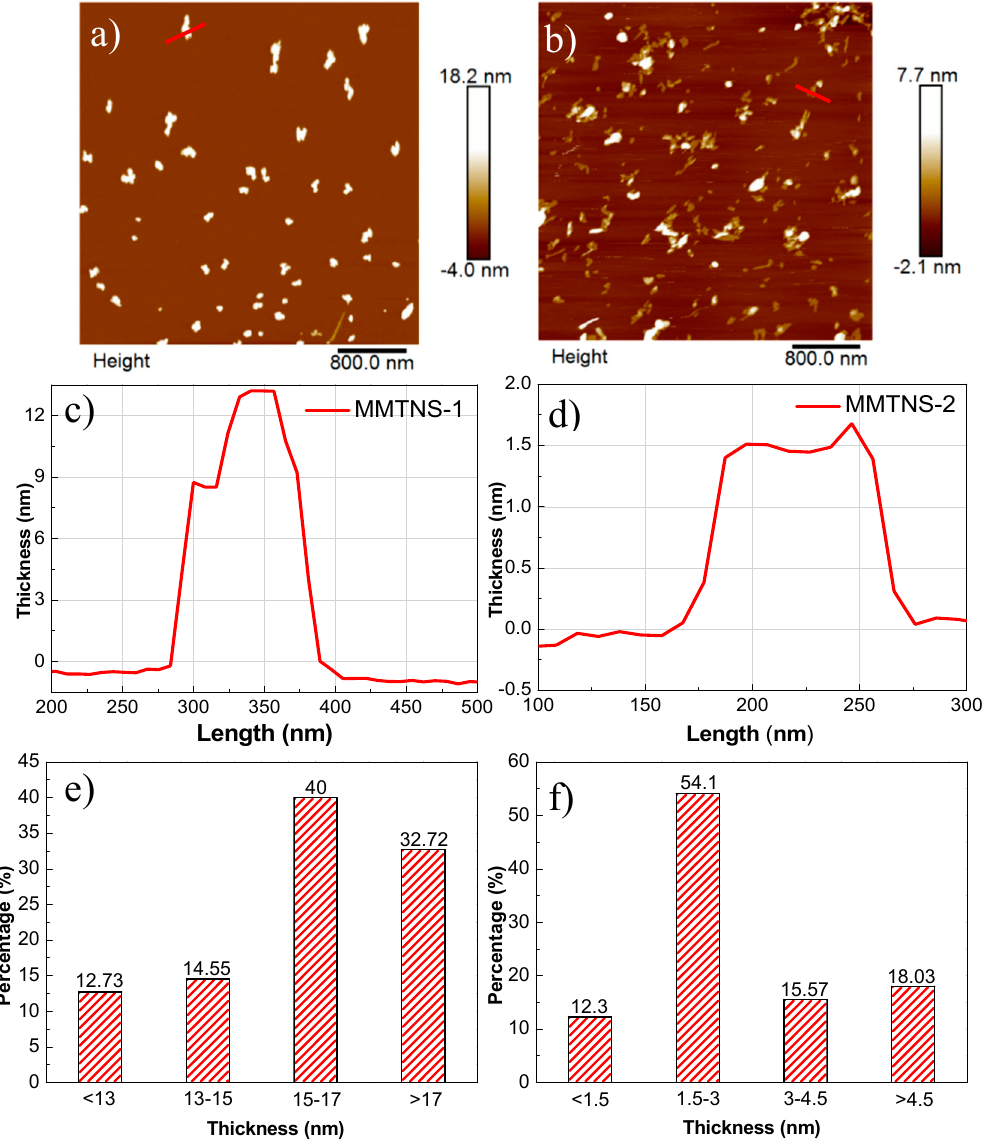
Figure 3. Typical 2D AFM morphology images (4 × 4 µ m, 512 pixels) of MMTNS-1 ( a ) and MMTNS-2 ( b ); topographic profile along the red lines in the corresponding images of MMTNS-1 ( c ) and MMTNS-2 ( d ); thickness distribution of MMTNS-1 ( e ) and MMTNS-2 ( f ).